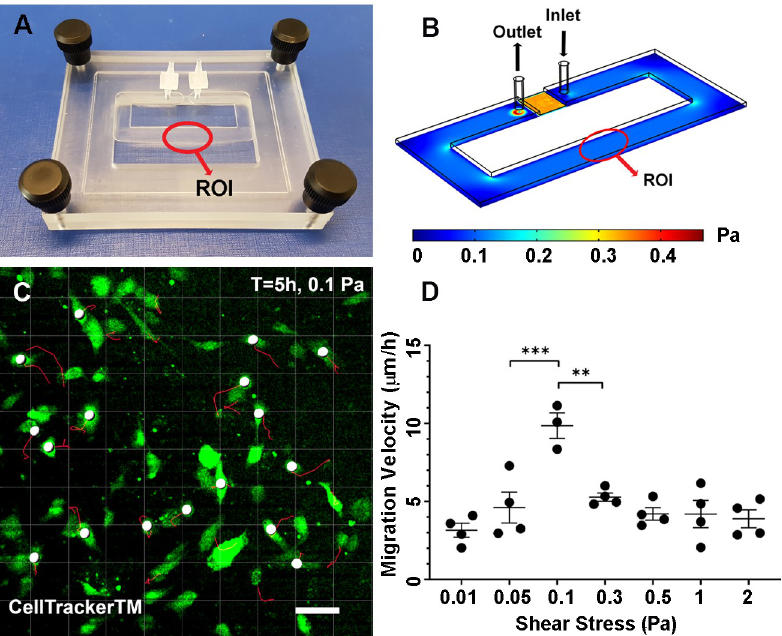
Fig 2. In vitro model of shear mediated migration. A) The custom designed flow chamber. ROI = Region of Interest. B) CFD results of shear stress throughout the flow chamber. C) Tracking of the migration of ECs using Imaris. Confluent monolayer of ECs is present but only 15% of the cells have been labelled with CellTracker to facilitate cell tracking. D) ECs have the highest migration rate when exposed to 0.1 Pa shear stress. n = 3-4 per shear stress level. Values are mean ± SEM. Significance is calculated by one-way ANOVA with Tukey’s test. � P < 0.01, and �� < 0.001. Scale bar = 50 μm